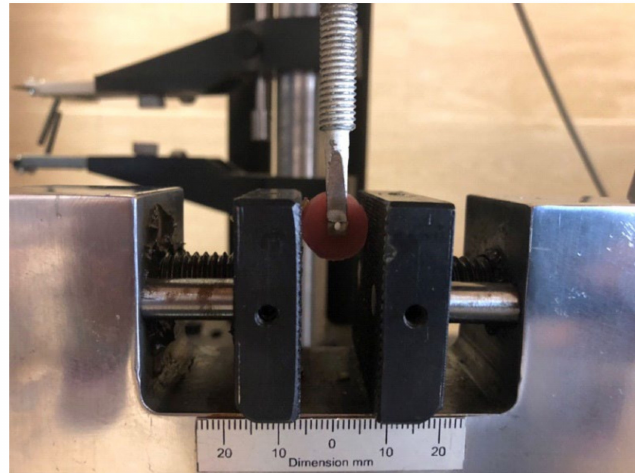
Figure 2. SBS test by using a mechanical universal testing